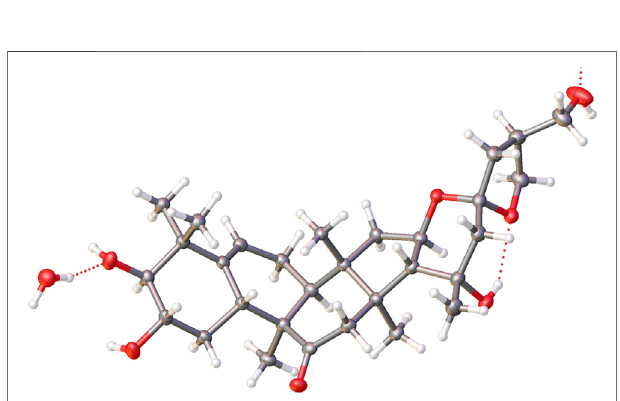
FIGURE 6 | ORTEP diagram of 5